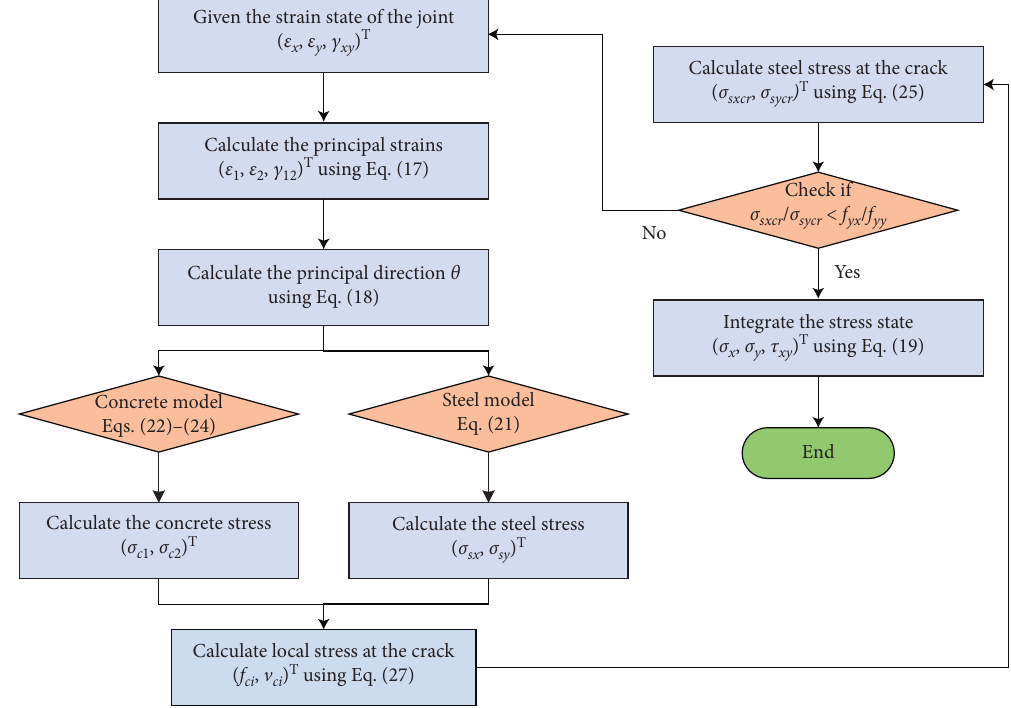
Figure 5: Flowchart of implementation of MCFT in calculating shear strength of internal RC joints. Table 6: Comparisons of predictive performance between GBRT and MCFT